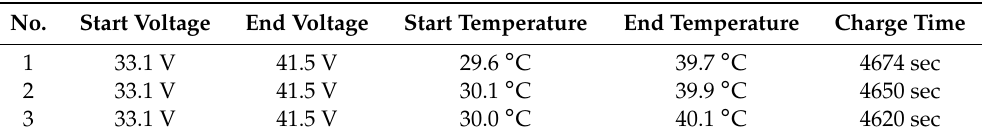
Table 4. Experimental results by pulse charging.